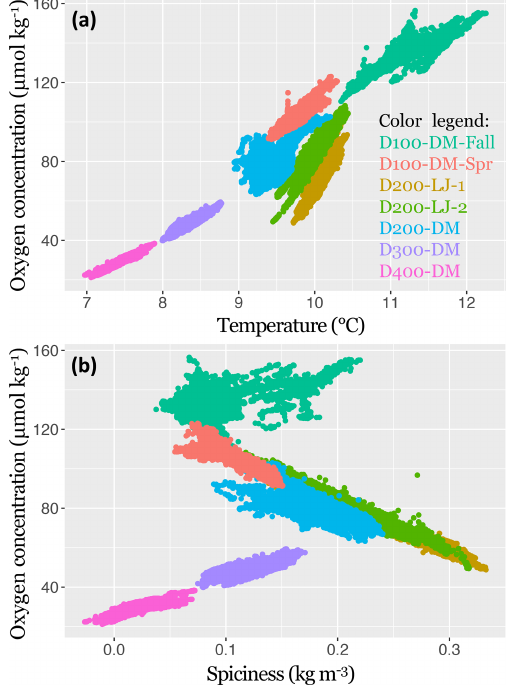
Figure 5. The 2017–2018 near-bottom dissolved oxygen concen- tration in the Southern California Bight shown in relation to tem- perature (a) and spiciness (b) . Data points represent samples taken every 5min with the SBE MicroCAT-ODO sensor during the seven deployments. Deployments are distinguished by color, as indicated in the color legend. Sampling dates for each deployment are given in Table